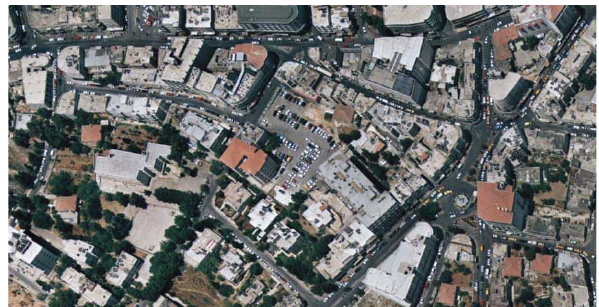
Fig. 9. Detail of the orthophoto used for GIS-analysis: the two dominant roof types in Ramallah can be identified: flat concrete roofs (grey) and sloping clay tile roofs